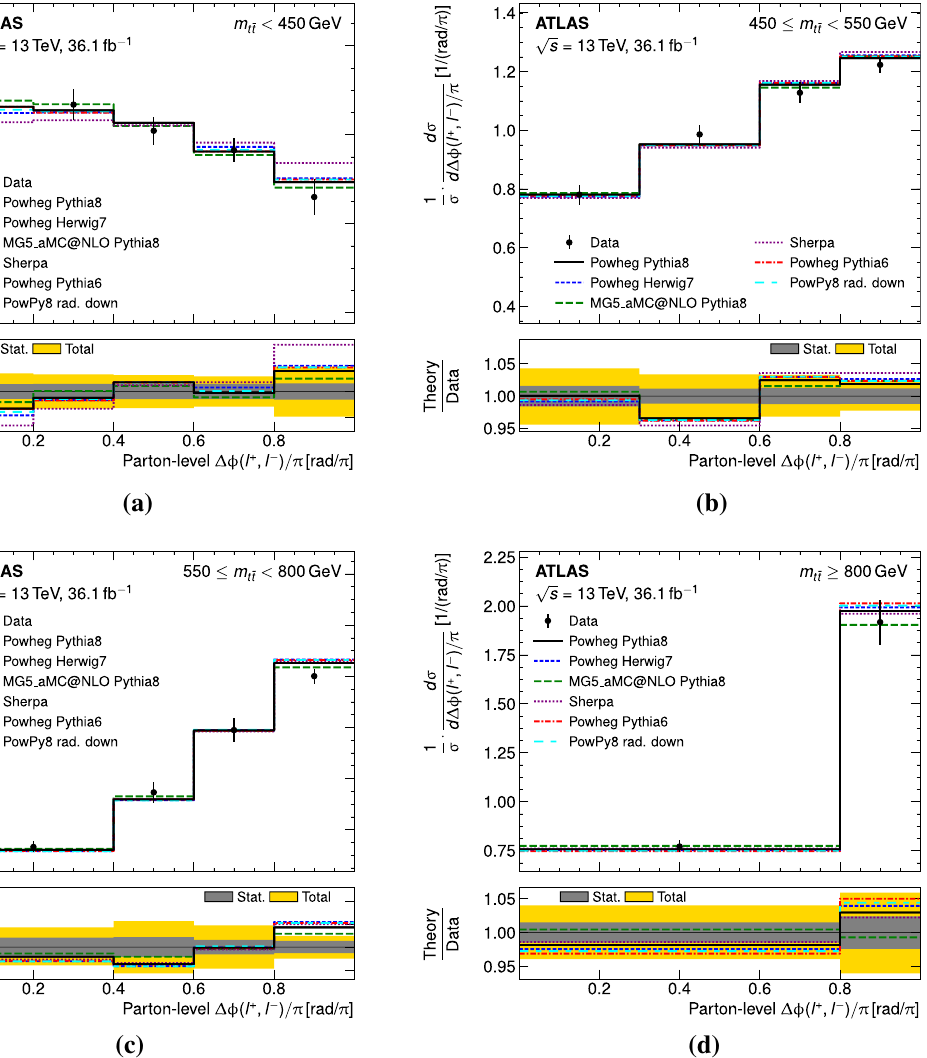
Fig. 8 The normalised parton-level differential cross-sections in four t ¯ t mass bins compared to predictions from Powheg , Mad- Graph5 _aMC@NLO and Sherpa , using the reconstructed selection: